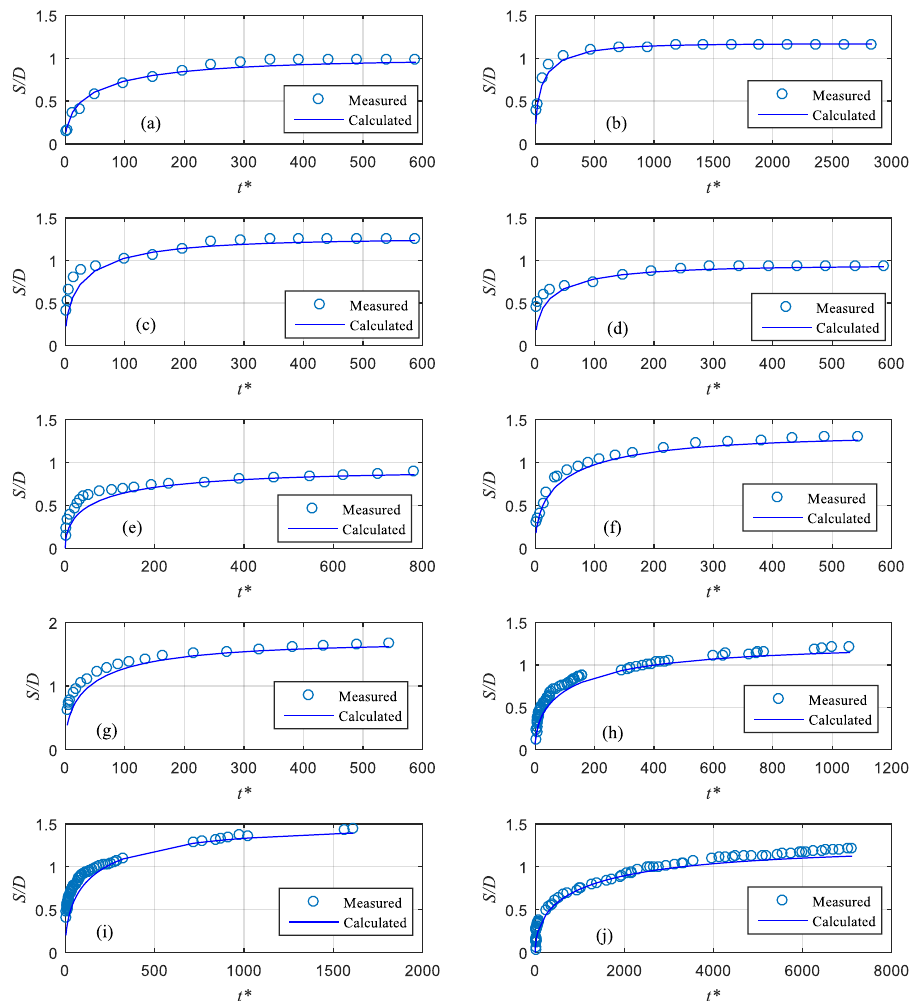
Figure 7. Comparison of temporal scour depth at pier front calculated by the present exponential